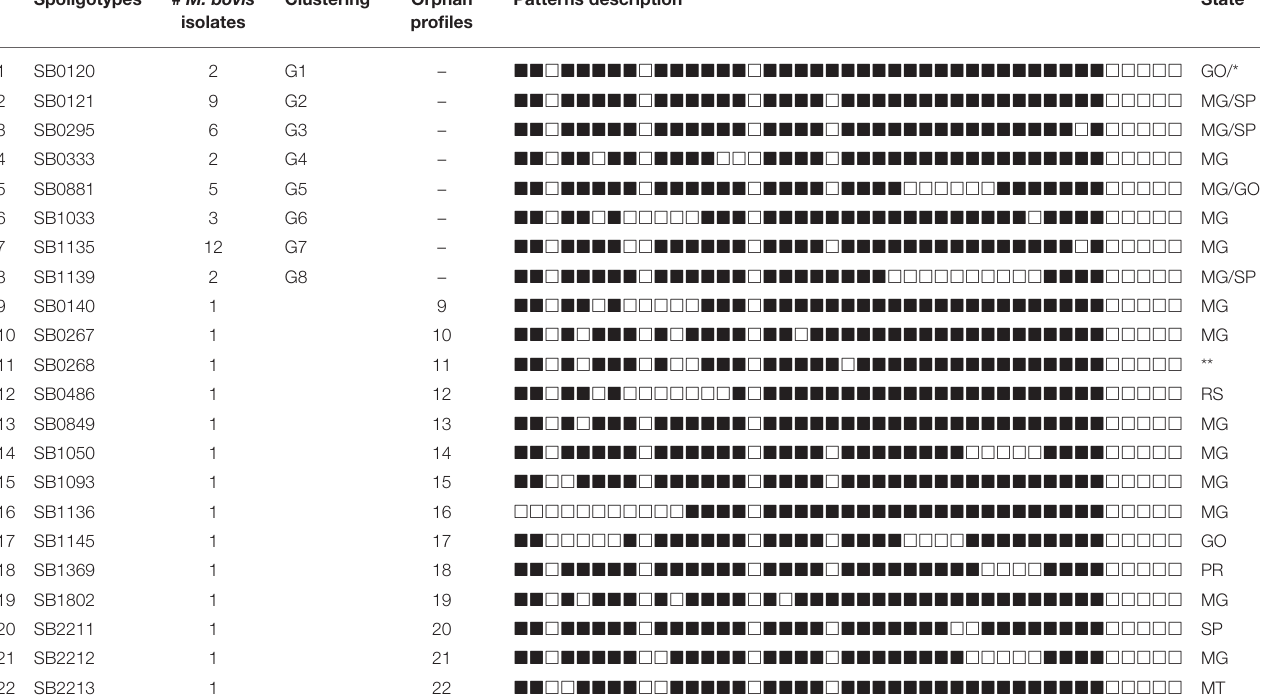
TABLE 2 | Spoligotypes of 55 Mycobacterium bovis isolates. Spoligotypes